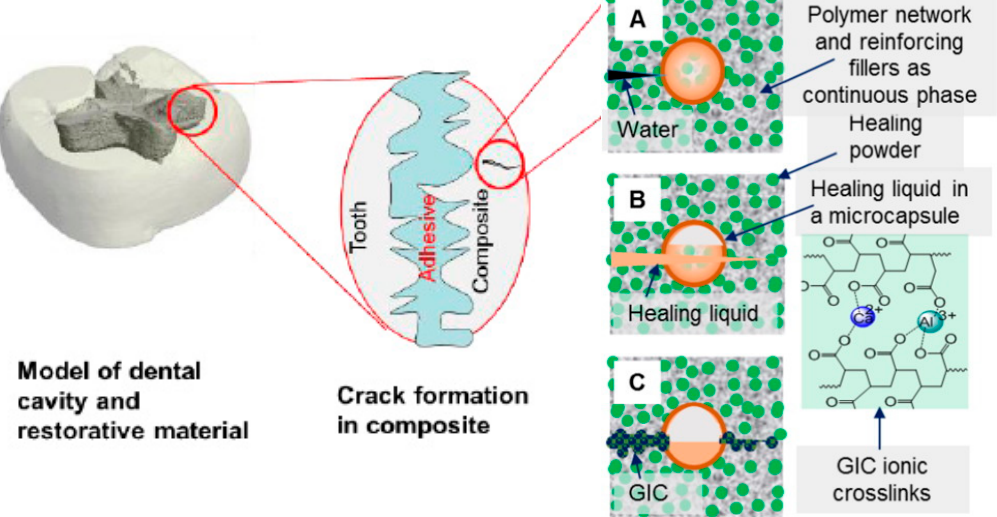
Figure 5. Self-healing steps of SHDC. ( A ) Fracture: A crack forms and water comes in, ( B ) Delivery: a microcapsule is broken due to crack propagation and releases HL, ( C ) Healing: the HL reacts with HP and produces GIC with the ionic crosslinking network and reprinted with permission from published work of Huyang, G. et al and coworkers [77].